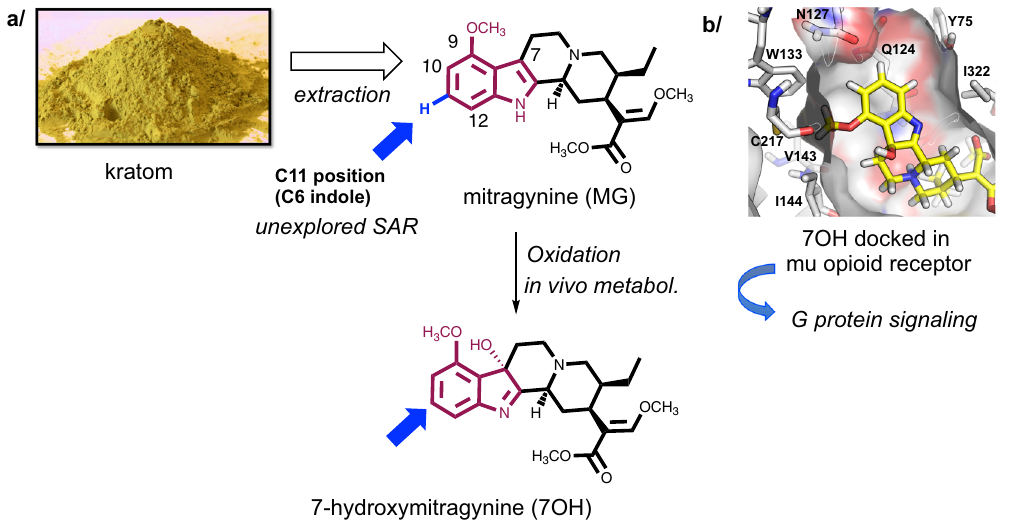
Fig. 1 The rationale for selective C – H bond functionalization of mitragynine (MG) and 7-hydroxymitragynine (7OH). a MG is readily obtained in multigram quantities from kratom powder by extraction, hence there is an incentive to develop selective functionalization of MG and related scaffolds via late-stage C – H bond functionalization. Speci fi cally, the C11 position has not been explored in terms of mu-opioid receptor (MOR) signaling and other biological effects, due to the lack of chemistries for functionalization of this position. b The top-right panel shows a docking pose of 7OH in human MOR highlighting the aromatic ring and the proposed binding pocket in the